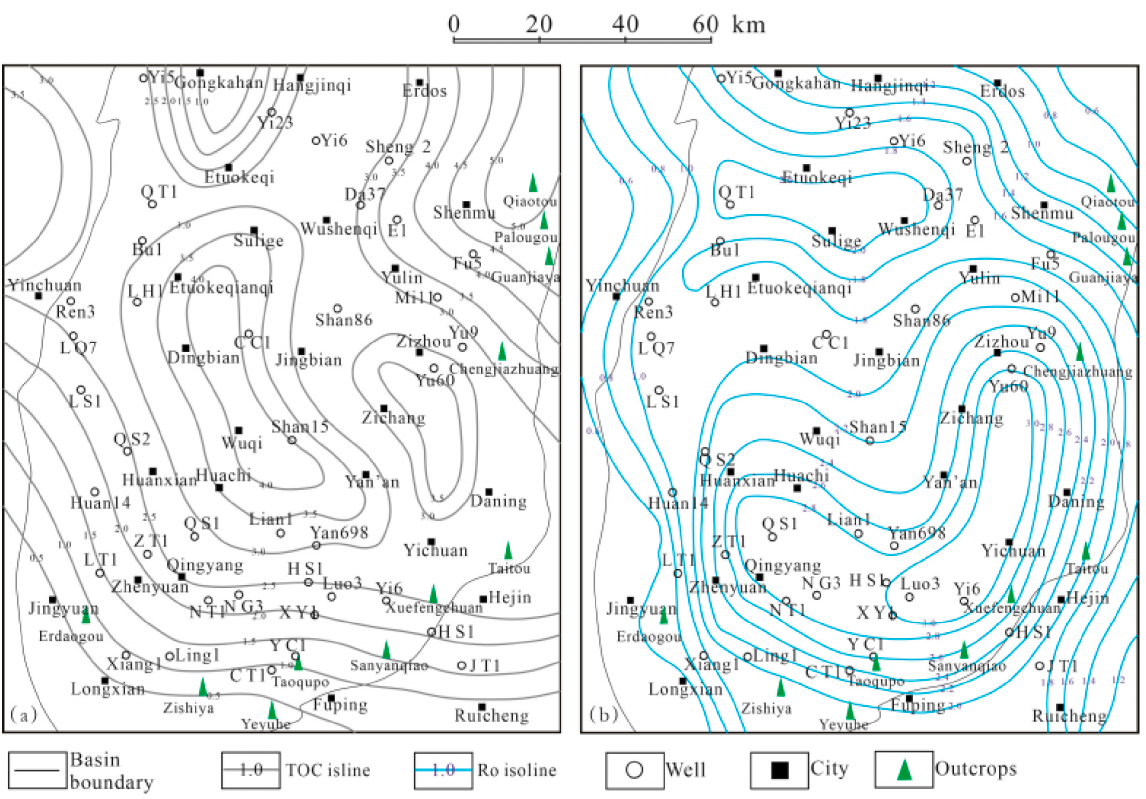
Figure 7. Features of TOC and thermal evolution of source rocks in the Ordos Basin. (a. TOC isoline of source rocks in the Ordos Basin; b. R 0 isoline of source rocks in the Ordos Basin.)